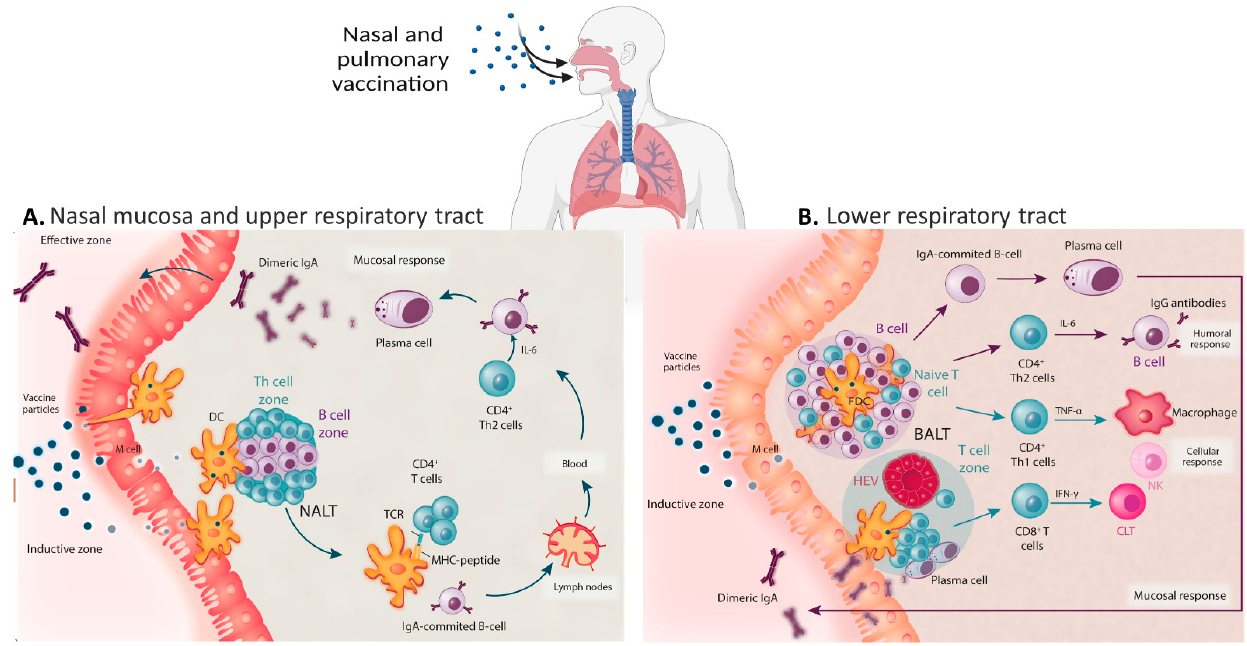
Figure 1. Mechanism of action and series of events following pulmonary vaccination; ( A ) Protective immune responses in the nasopharynx-associated lymphoid tissue (NALT), with the pathogen-mediated reaction stemming mainly from secretory IgA antibodies produced by mucosal epithelial cells. ( B ) Humoral immune response in the lower respiratory tract with bronchus-associated lym- phoid tissue (BALT) stimulates humoral and mucosal/local immune responses. Abbreviations: DC, dendritic cell; NK, natural killer; TCR, T cell receptor; CTL, cytotoxic T lymphocyte. Some of the objects created using